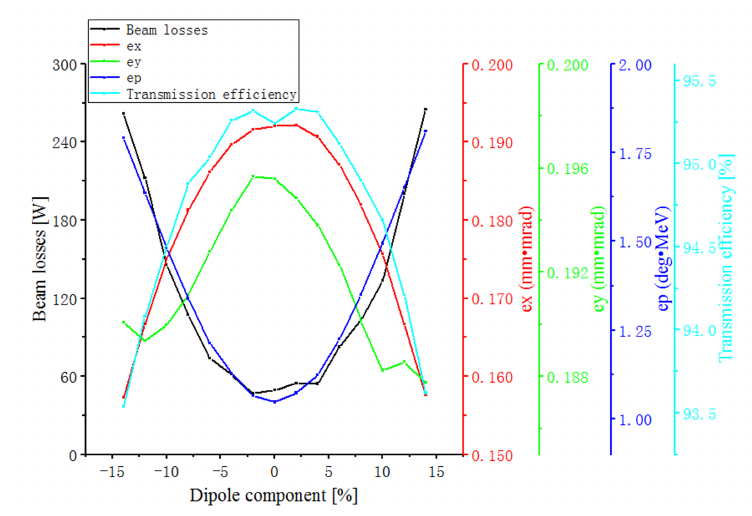
Figure 8. Effect of dipole field components on transmission